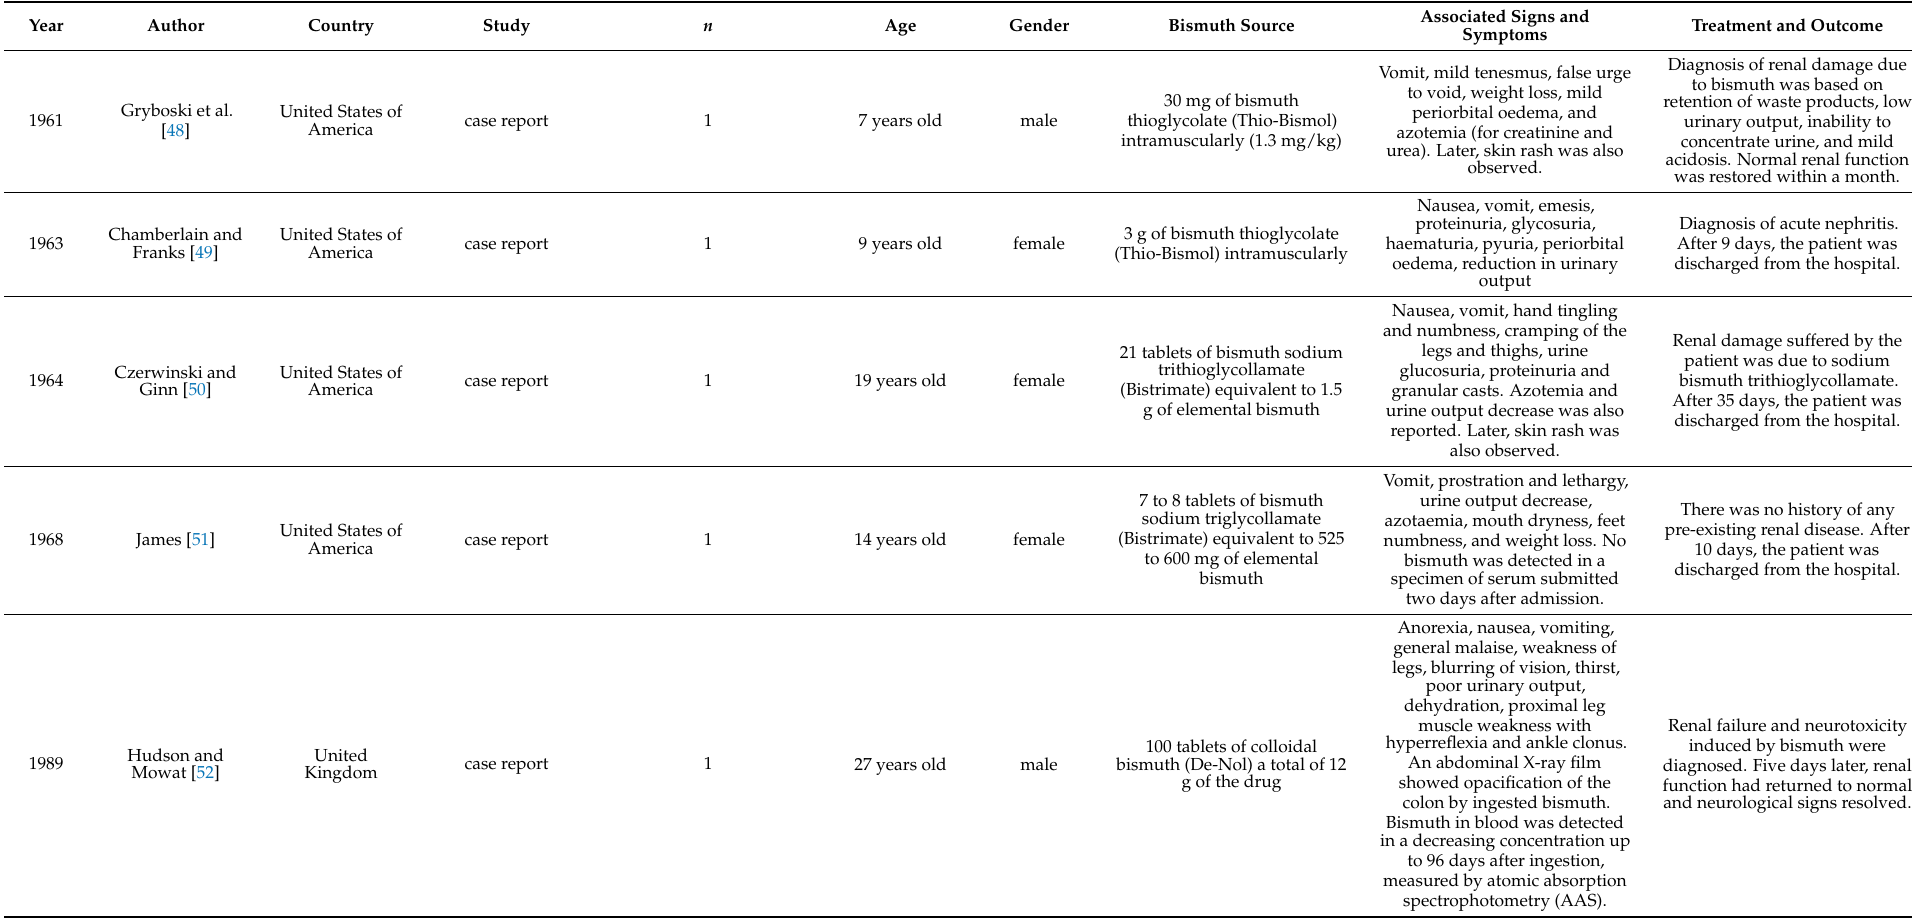
Table 1. Data extracted from the included